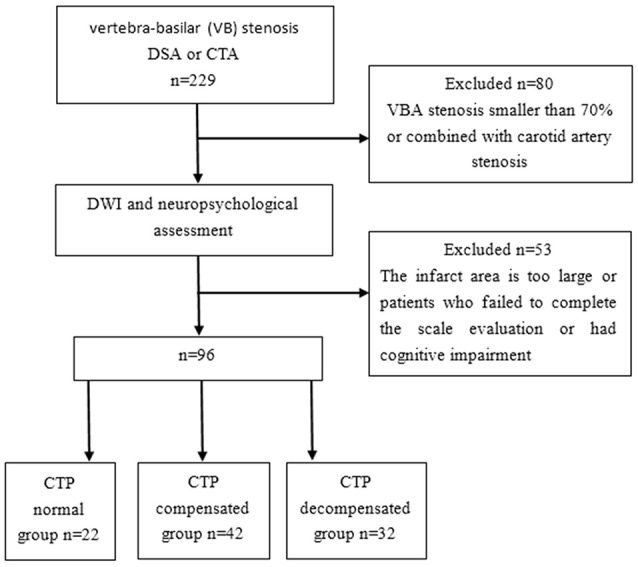
Recruitment diagram.